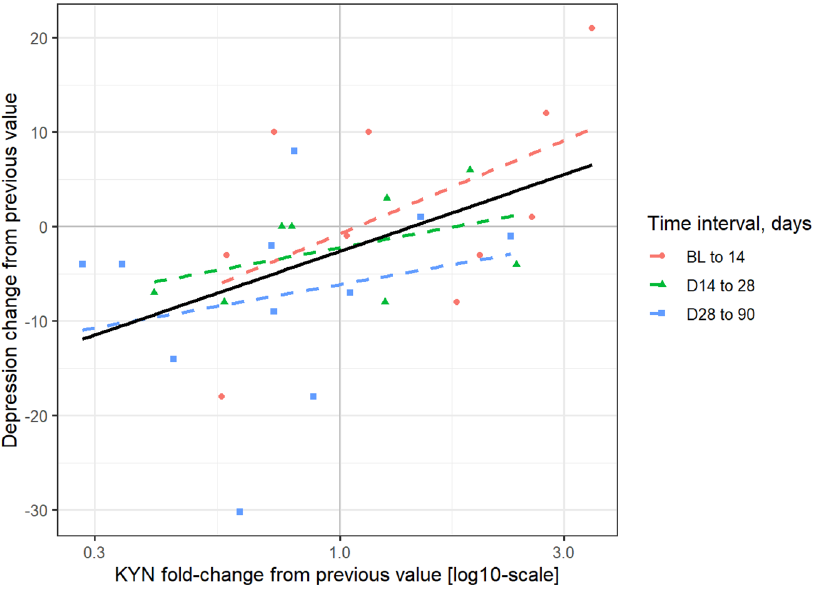
Fig. 4 Spearman ranked correlation between kynurenine and depression fold-changes. BL baseline, KYN Kynurenine. Kynurenine concentration changes over time between timepoints was signi fi cantly correlated to change in depression scores between the same timepoints ( n = 15, p =